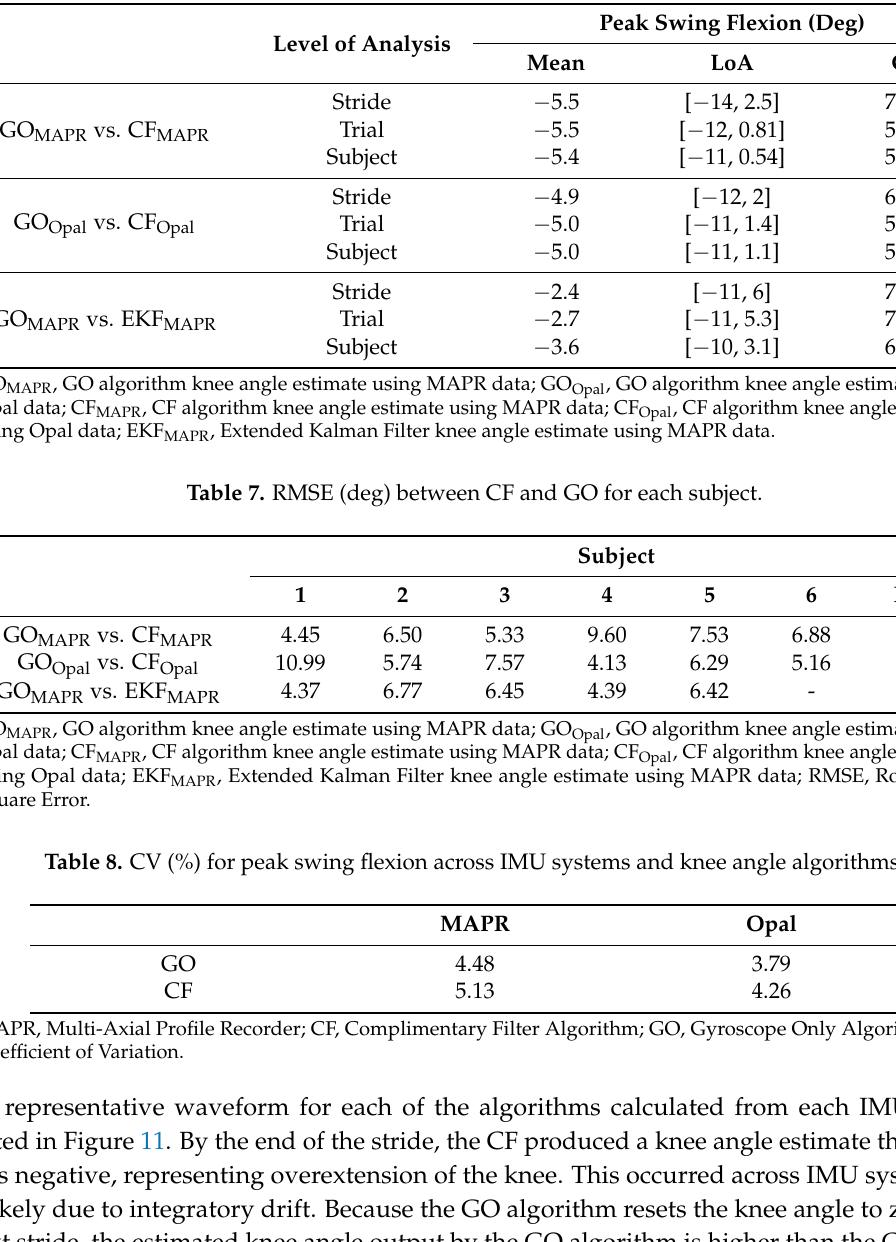
Table 6. Bland–Altman analysis of peak swing flexion within algorithms across IMU Systems. Peak Swing Flexion (Deg) Level of Analysis Mean LoA CV Stride − 5.5 [ − 14, 2.5] 7.2% GO MAPR vs. CF MAPR Trial − 5.5 [ − 12, 0.81] 5.7% Subject − 5.4 [ − 11, 0.54] 5.4% Stride − 4.9 [ − 12, 2] GO Opal vs. CF Opal